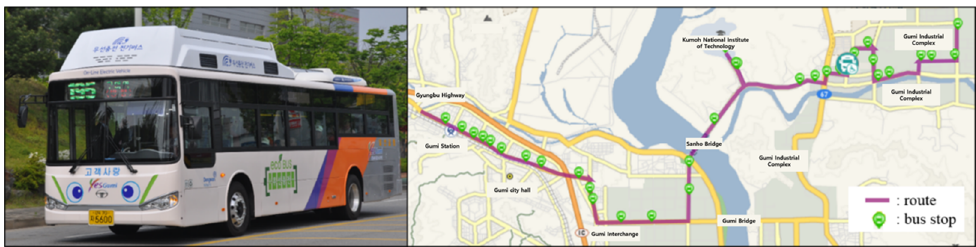
Figure 1. OLEV bus and operation route installed at Gumi city.